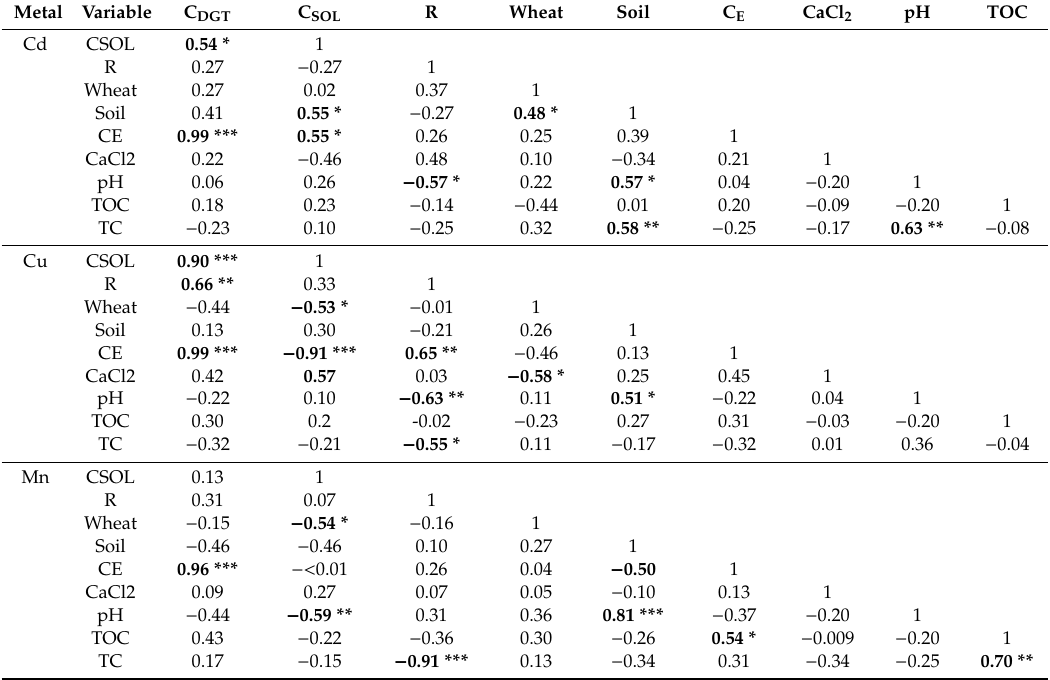
Table 3. Pearson correlation coe ffi cients (r) between metal concentrations in wheat tissues, soil physiochemical properties and extractable metals measured by di ff erent methods in soil. Statistically significant values ( p < 0.05) are in bold